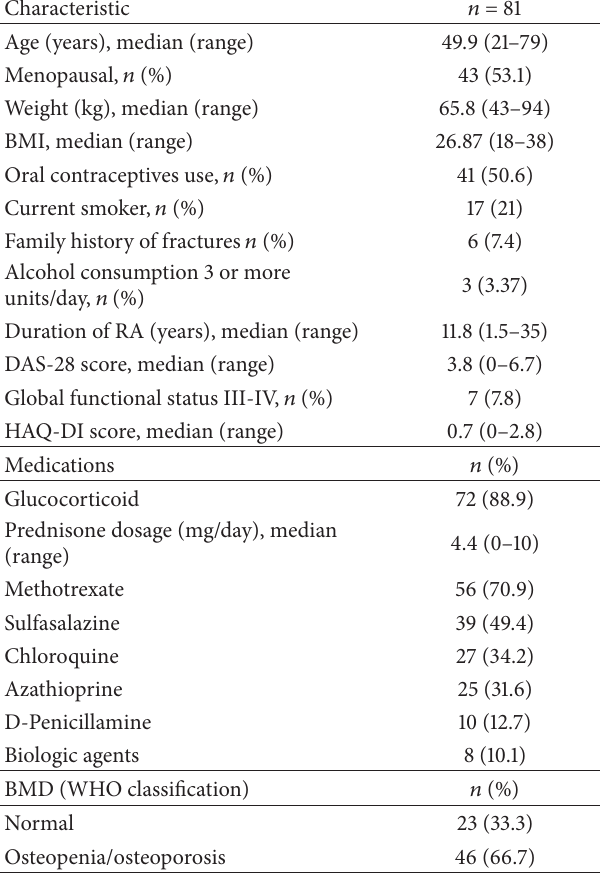
Table 2: Clinical characteristics of study